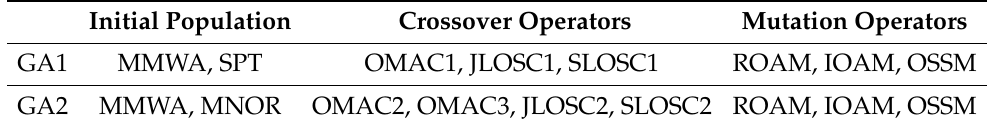
Table 2. Common and different elements between the two genetic